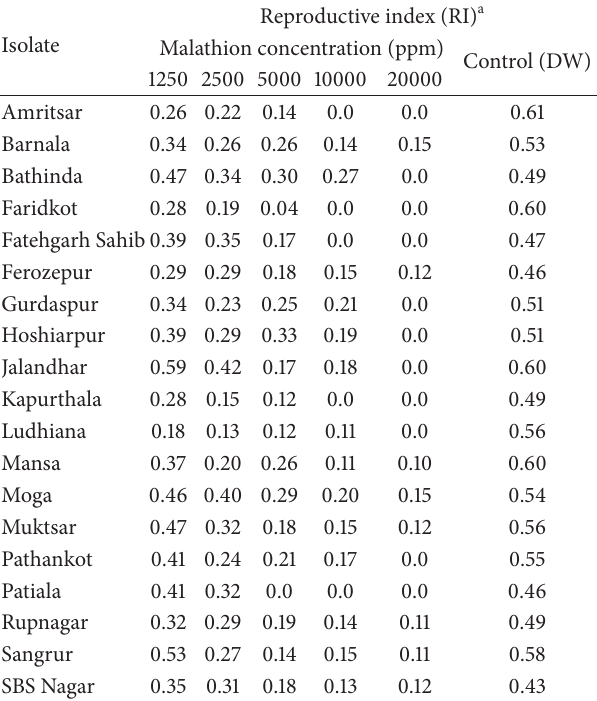
Table 3: Effect of malathion on RI of field isolates of R. ( B. ) microplus .